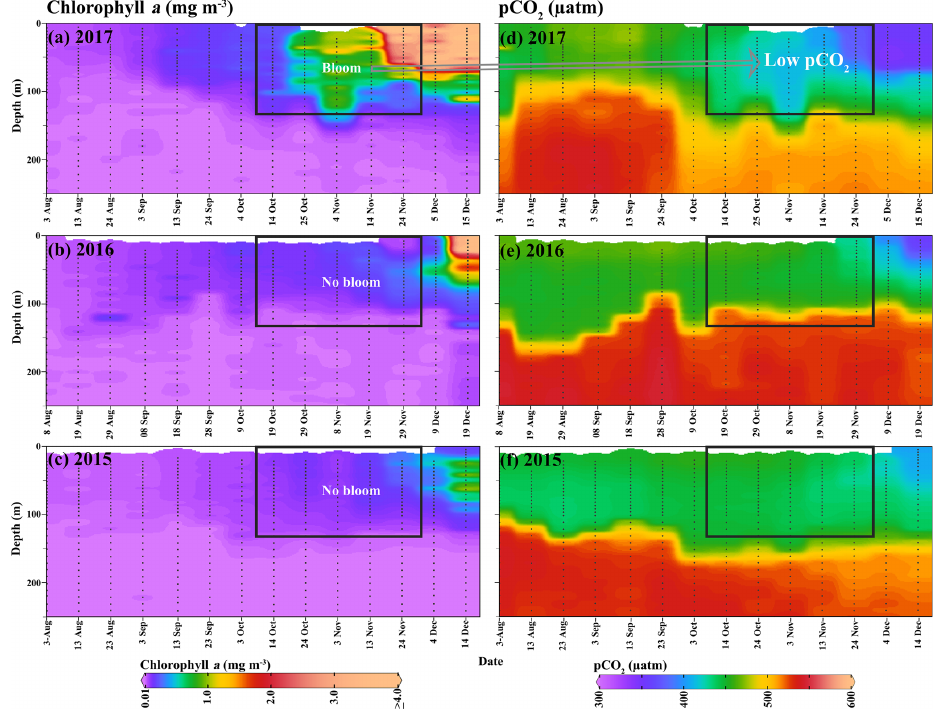
Figure 5. An Argo float (ID-5904468) located on the Maud Rise seamount shows profiles of (a–c) chlorophyll a and (d–f) p CO 2 from August to December (2015–2017). The marked rectangle in (a) shows the bloom condition from October to November 2017, and the bloom was absent during the 2 preceding years (2015 and 2016). Low p CO 2 values were observed, corresponding to the bloom occurrence.